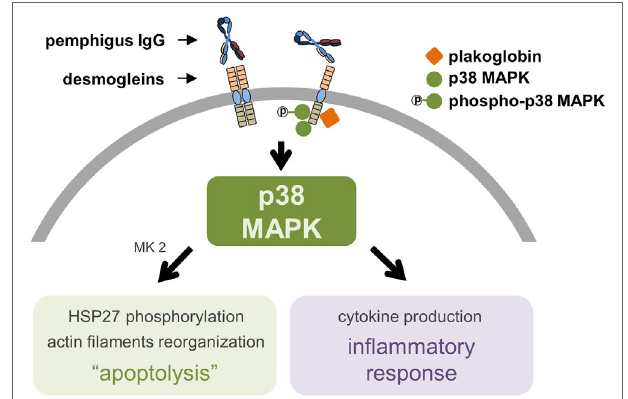
FiGUre 1 | The proposed central role of p38 mitogen-activated protein kinase (p38 MAPK) in pemphigus’ pathogenesis. The molecular complex supposed to be formed by desmoglein (DSG, specifically DSG3, as of the gap for data on DSG1), plakoglobin, and p38 MAPK induces keratinocyte apoptolysis and a local inflammatory response after binding of pemphigus IgG to extracellular domains of DSG. A phosphorylation cascade involving p38 MAPK, MAPK activated protein kinase 2 (MK2), and heat shock protein 27 (HSP27) leads to the collapse of the cytoskeleton and ultimately to keratinocyte apoptosis. The central role of p38 MAPK includes the production of pro-inflammatory